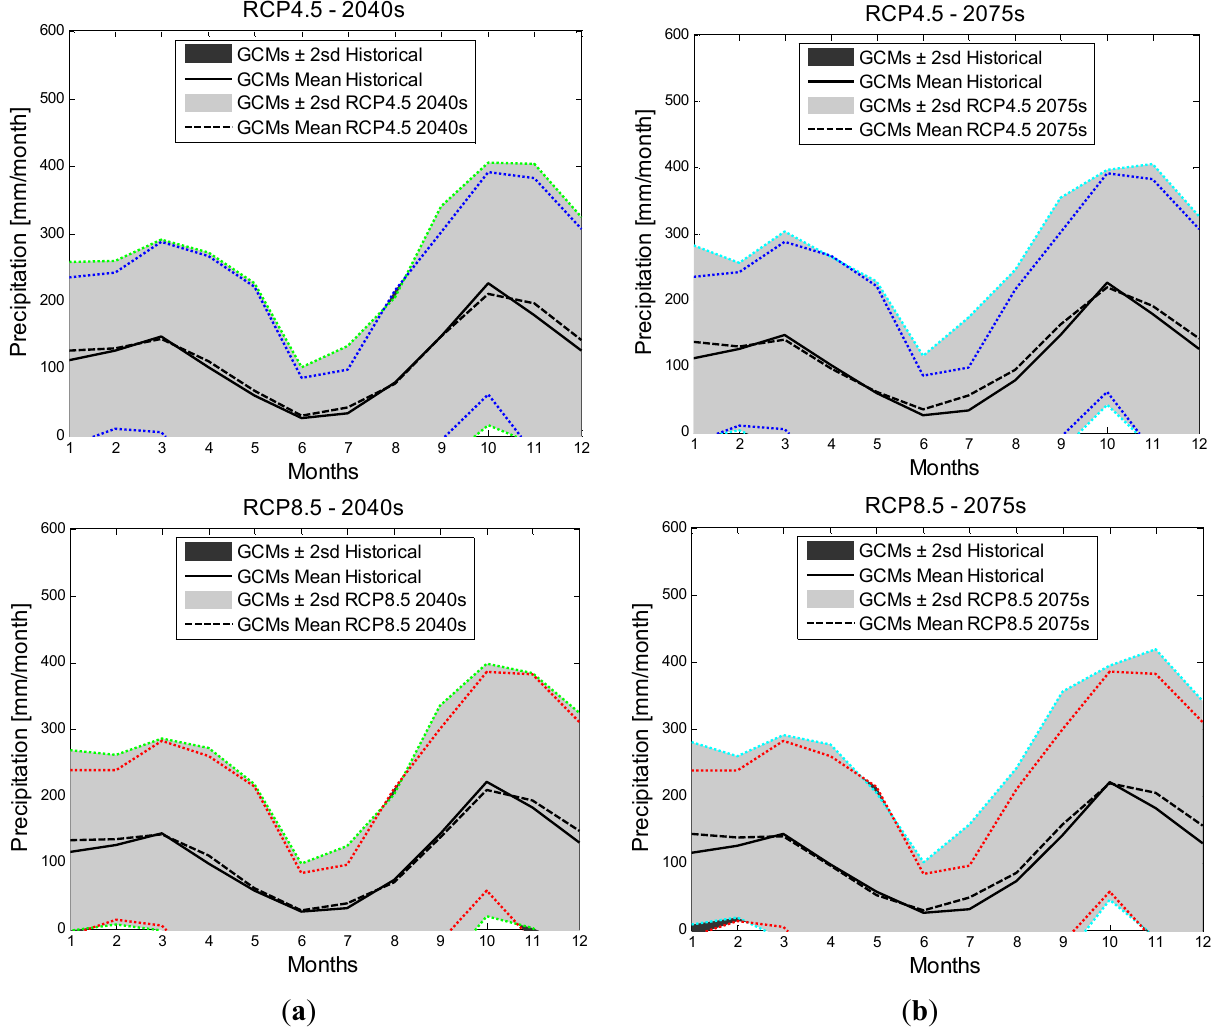
Figure 10. Seasonal variation of average monthly precipitation for observed and GCM historical, RCP4.5 and RCP8.5 series for ( a ) 2040s; ( b ) 2075s. The colored dotted lines indicate the extent of twice the historical standard